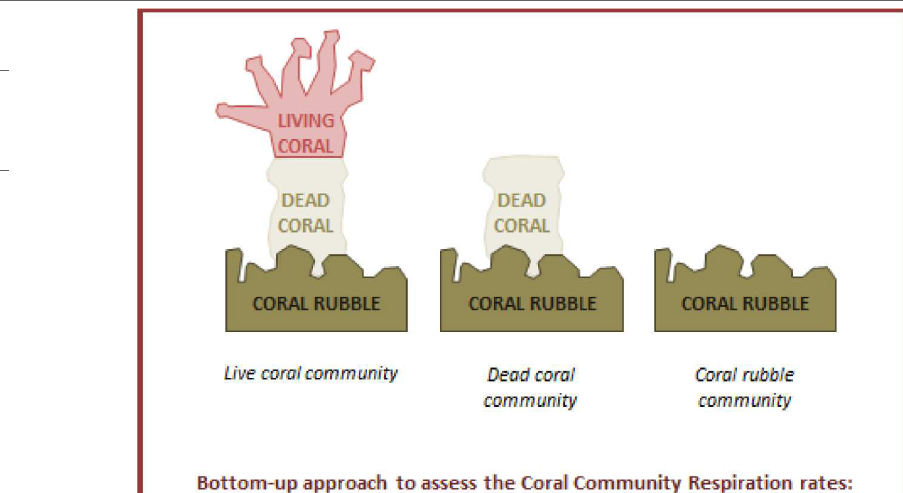
TABLE 4 | Structure and Community Respiration (CR) rates of Reef R1 based on ROV video survey images and incubation rates.